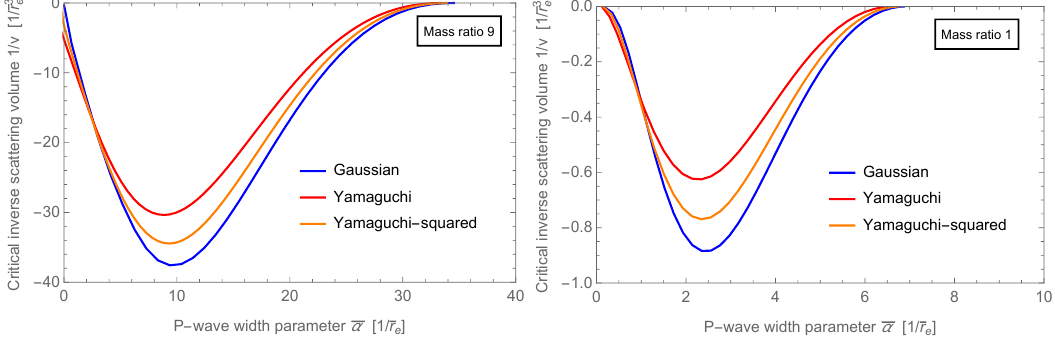
Figure 11: Critical inverse scattering volume 1 / v parameter¯ α . Left panel: for a mass ratio 9. Right panel: for a mass ratio